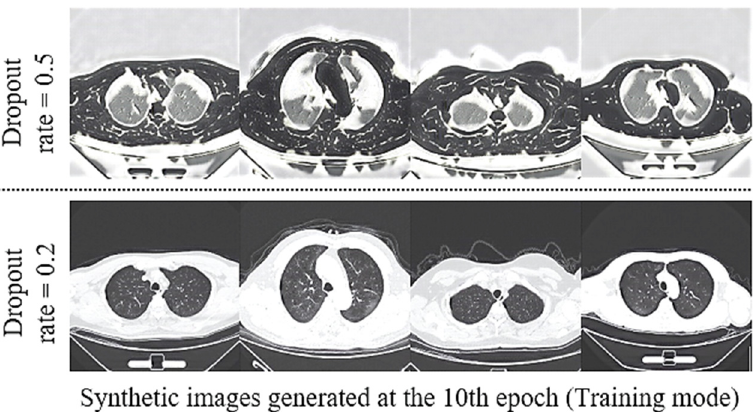
Figure 8. Comparison of the synthetic outputs generated from sRD-GAN trained with six RD-blocks with a dropout rate of 0.5 and a reduced dropout rate of 0.2 for the three middle RD-blocks.